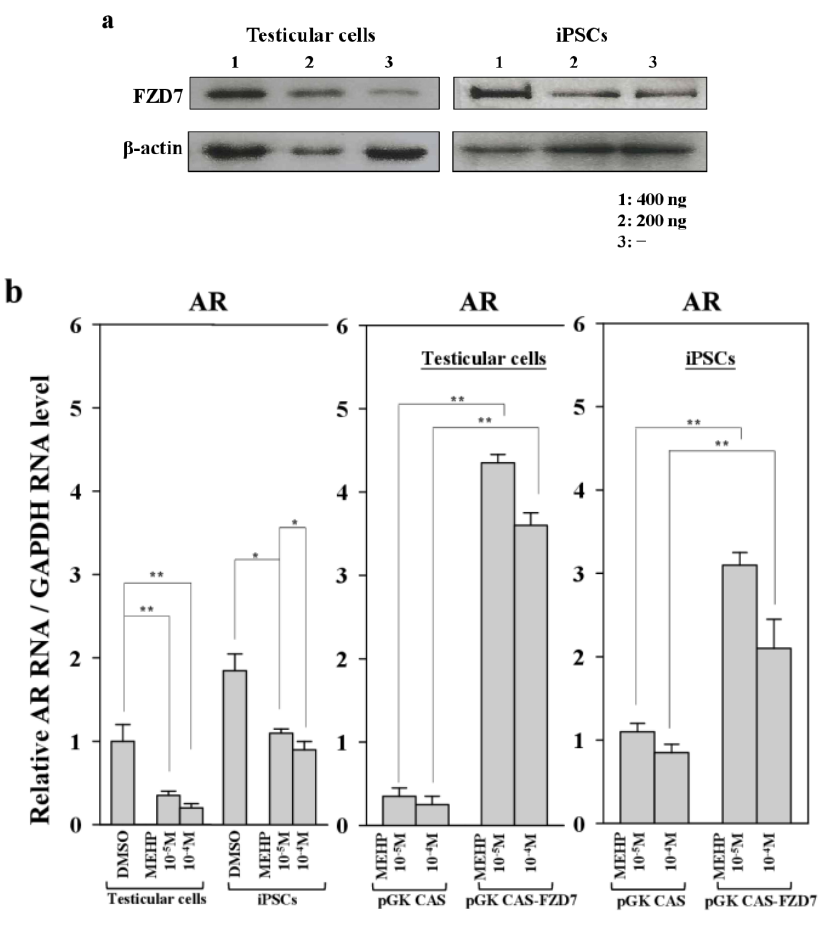
Figure 7. Effects of the forced expression of the Frizzled receptor FZD7 on gene expression and apoptosis in testicular cells and iPSCs. ( a ) Protein expression of FZD7 in bovine iPSCs and testicular cells transfected with pGK-CAS-FZD7 (200 and 400 ng) were examined. After cultivation of transfectants for 24 h, MEHP (10 − 4 and 10 − 5 M) were added and cultured for another 24 h and then subjected to Western blotting, as described in the Experimental Section; ( b ) pGK-CAS-FZD7 (400 ng) or each control vector pGK-CAS (400 ng) was introduced into bovine iPSCs, which were cultured for 24 h; 10 − 4 M MEHP was added and the cells cultured for another 24 h. The relative expression of AR was quantified by quantitative polymerase chain reaction (qPCR), as described in the Experimental section; ( c ) Effect of FZD7 on apoptosis. Apoptotic cells were quantified as described in the Experimental Section. Values measured with DMSO were defined as 1. Values indicated are means ± SEM, n ≥ 3; * p < 0.05, ** p <